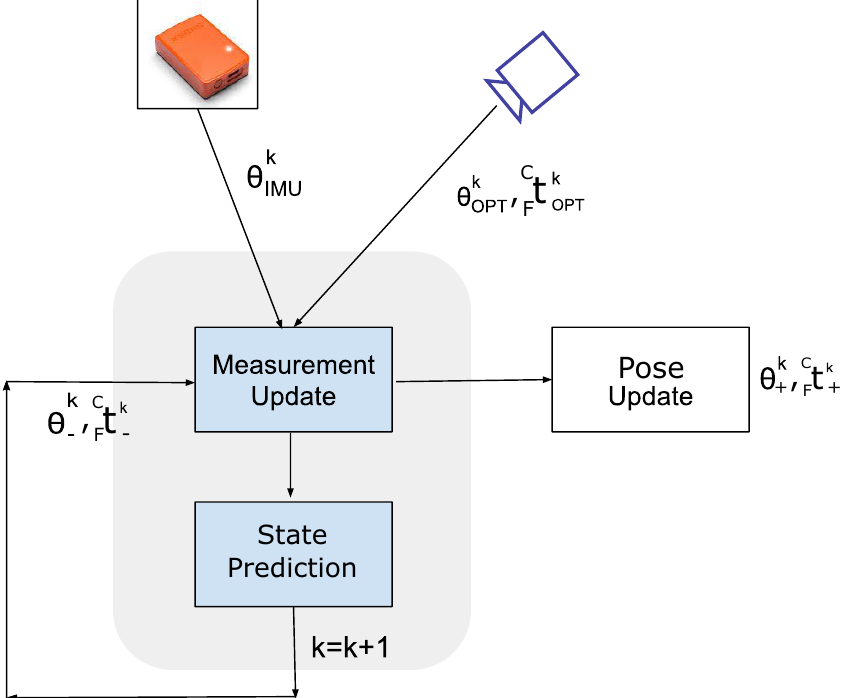
Figure 5. Block Diagram of the Kalman Filter